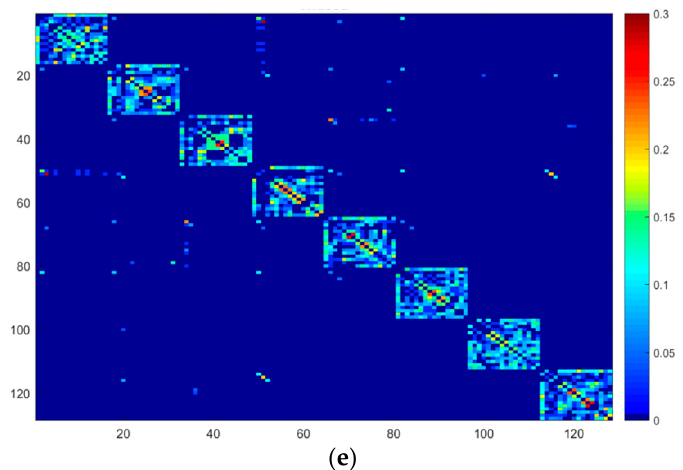
Figure 3. The similarity matrix of unlabeled data from the PF01 dataset with eight classes and one sample from each class selected as the labeled data. ( a ) The similarity matrix of Adaptive k-NN graph based on VGG Face-FC6 with K = 6. ( b ) The similarity matrix of k-NN graph based on VGG Face-FC6 with K = 6 and σ = 0.05. ( c ) The similarity matrix of correlation graph based on VGG Face-FC6 with K = 6, which is before LP. ( d ) The similarity matrix of the correlation graph after 10 iterations of LP. ( e ) The similarity matrix of the fused graph.